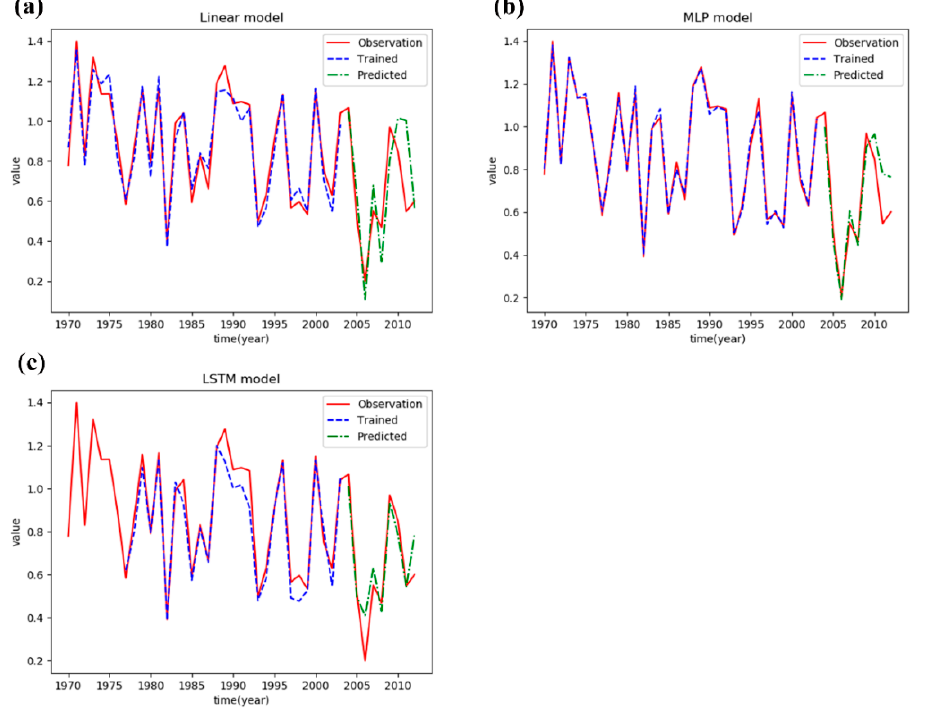
Figure 5. Trained and predicted trajectories of groundwater recharge based on ( a ) linear regression, ( b )MLP and ( c )LSTM models.